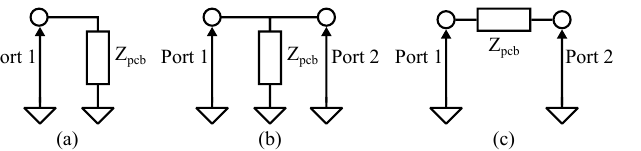
Figure 13. Techniques for measuring S parameters: ( a ) 1-port reflection; ( b ) 2-port shunt-thru; and ( c ) 2-port